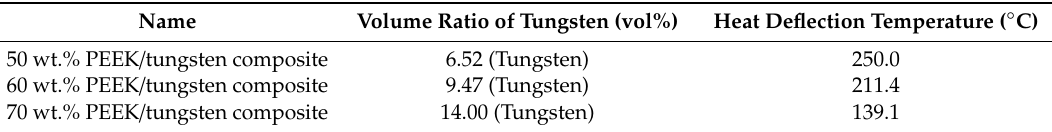
Table 4. Heat deflection temperatures of new shielding